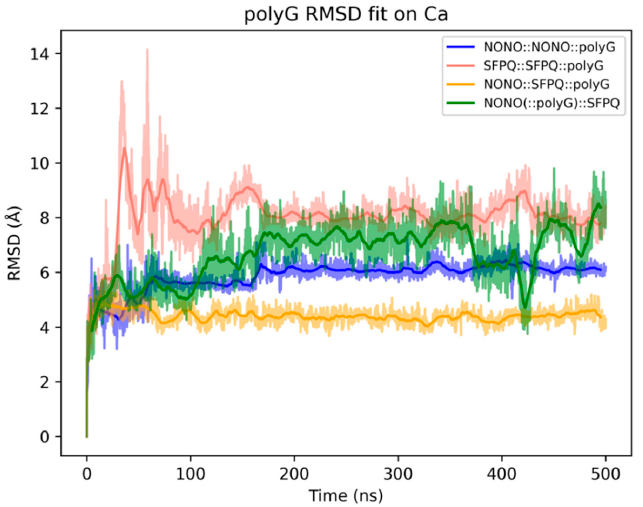
Figure 6. Stability of DBHS::polyG dimers during MD simulation. RMSD was calculated on polyG atoms after fitting each frame to the solute α -carbons.